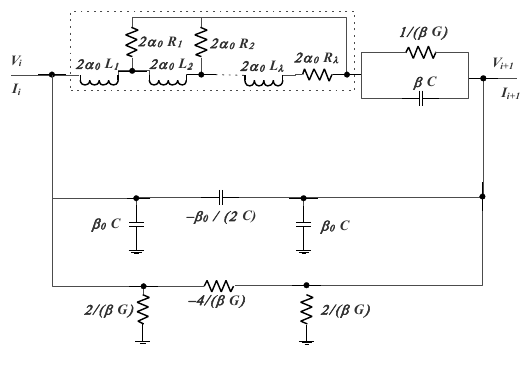
Fig. 4. Circuit topology of the real pole-zero subsection